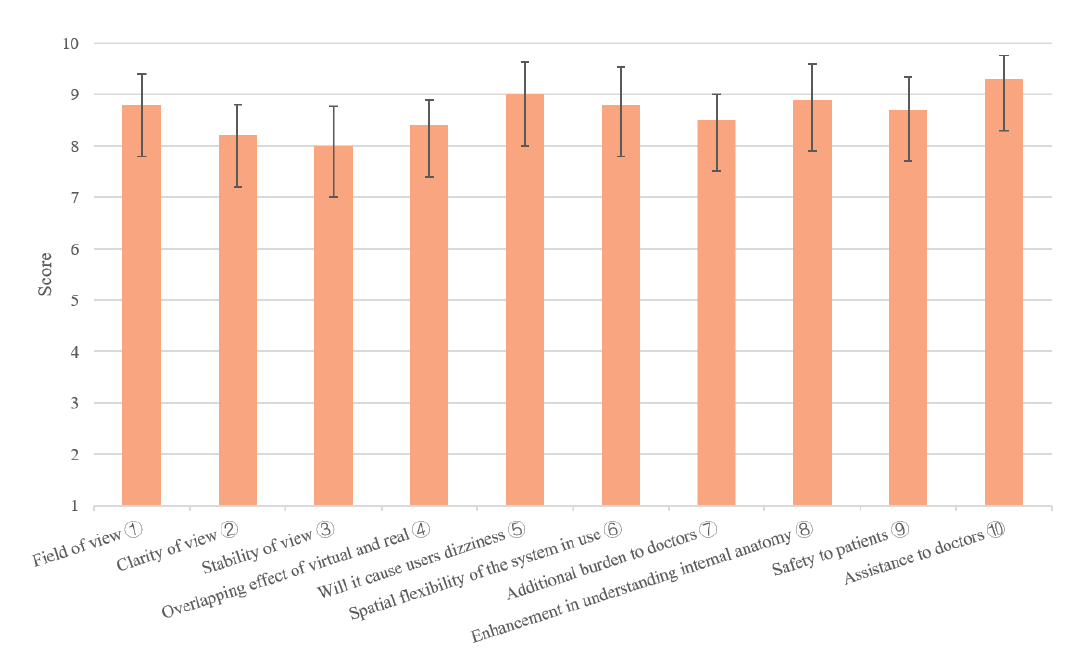
Figure 14. Results of the qualitative analysis ( 5 (cid:13) higher score means less dizziness; 7 (cid:13) higher score means less